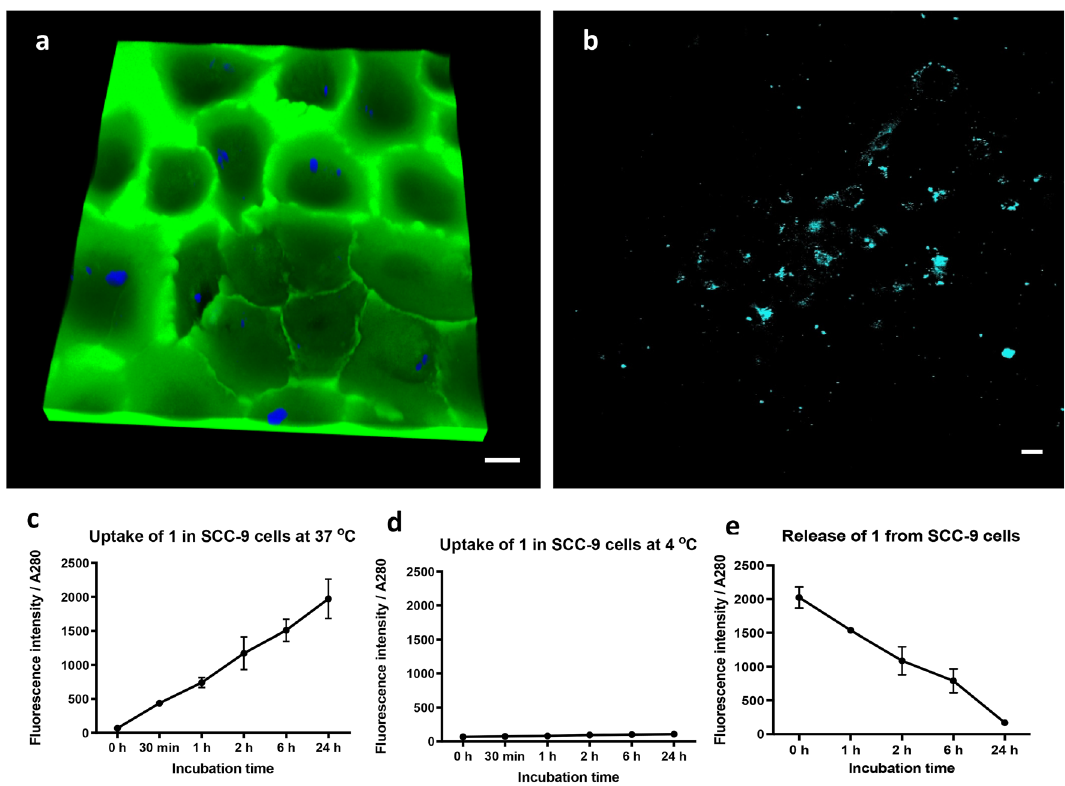
Figure 2. Internalization and release of compound 1 by SCC-9 cells. ( a ) 3D confocal microscopy of compound 1 in SCC-9 cells. Immediately prior to imaging, a concentration of 0.1 μM fluorescein sodium salt was added to the medium to allow visualisation of the cell outline. Bar is 20 μm. Images were analysed using Leica Application Suite X version 3.5.5.19976, www. leica- micro syste ms. com, 3D rendering was performed using Imaris version 9.5, www. imaris. oxinst. com. ( b ) Multiphoton microscopy of compound 1 in SCC-9 cells. Bar is 20 μm. Images were analysed using Olympus Fluoview FV10-ASW version 4.0, www. olymp us- lifes cience. com. ( c , d )